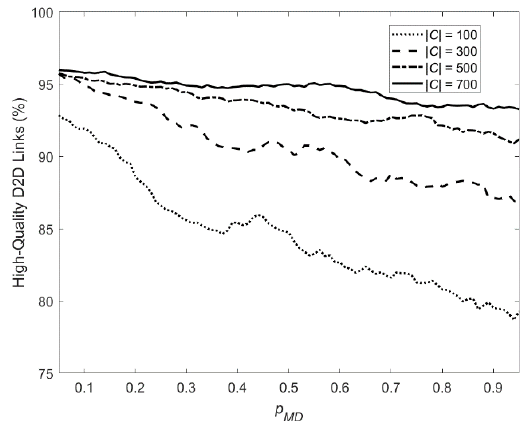
Figure 13. The percentage of D2D links with the desired quality of service (QoS) vs. the misdetection probability (i.e., 𝑝 𝑀𝐷 ) for different sizes of |Ϲ| .